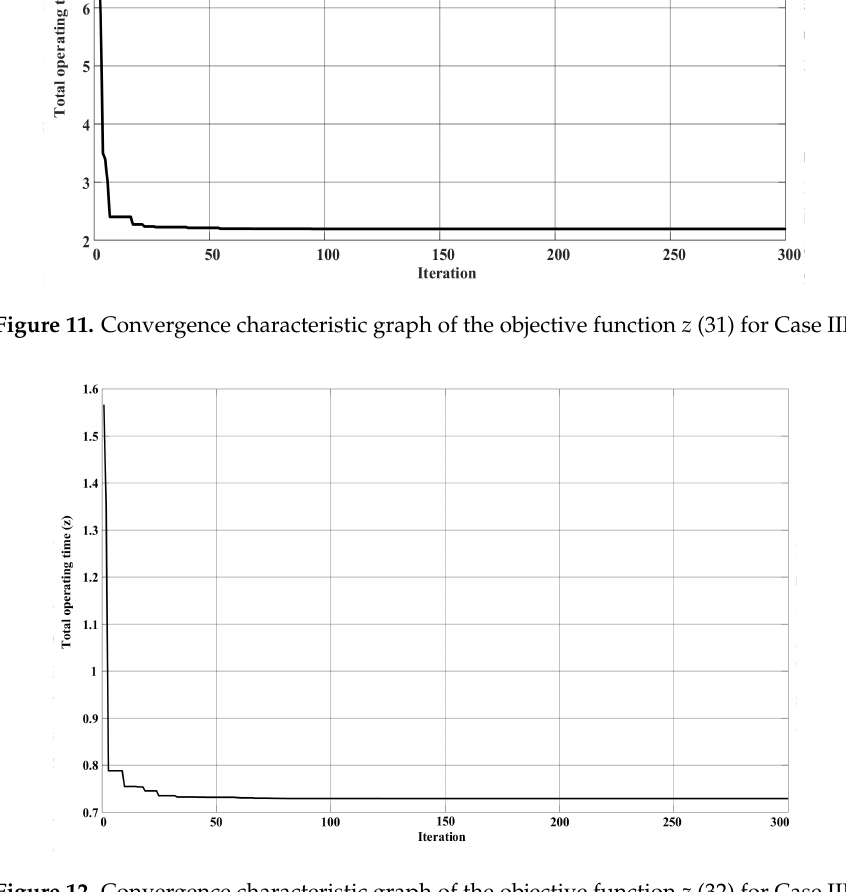
Figure 12. Convergence characteristic graph of the objective function z (32) for Case